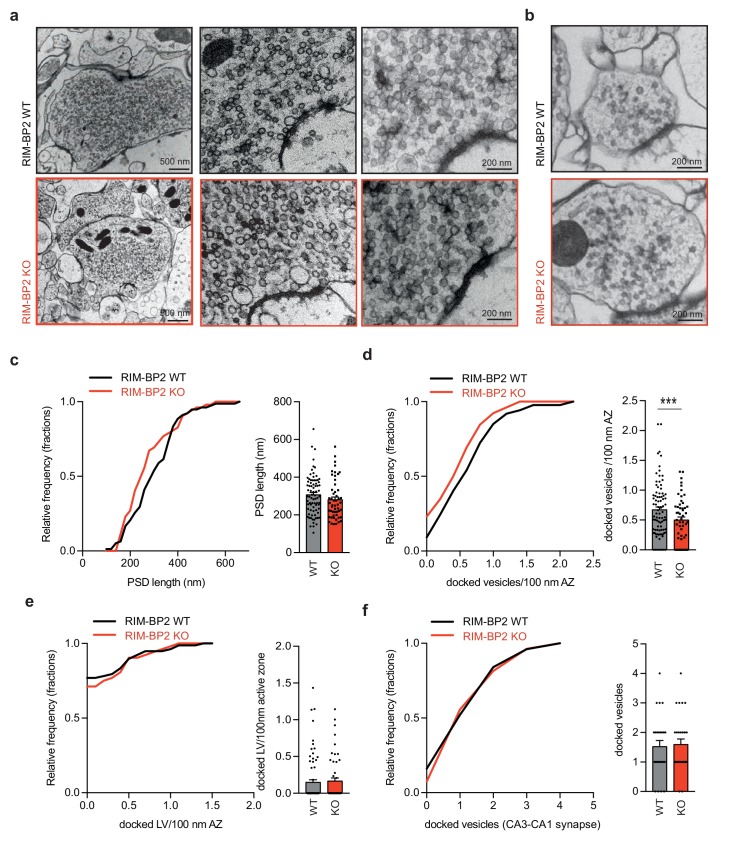
Loss of RIM-BP2 specifically affects vesicle docking at MF synapses.Representative EM images of MF synapses from acute hippocampal slices obtained from RIM-BP2 KO (black: three animals/each2-3 slices/78 active zones) and WT (red: three animals/2–3 slices each/52 active zones) mice. (b) Representative EM images of CA1 synapses from acute hippocampal slices obtained from RIM-PB2 KO (black: three animals/each2slices/27 active zones) and WT (red: three animals/2 slices each/25 active zones) mice. (c) Frequency distribution and bar graph show no difference in the size in the post-synaptic density (PSD) in MF active zones from WT or RIM-BP2 KO slices. (d) Frequency distribution and bar graph show a reduction of docked vesicles per 100 nm of the active zone at RIM-BP2 KO MF synapse compared to WT MF synapses. (e) Frequency distribution and bar graph depict no difference in the number of docked large vesicles (LV) (vesicle diameter >70 nm) (f) Frequency distribution and bar graph of docked vesicles at CA3-CA1 synapses show no difference between WT and RIM-BP2 KO. Values represent mean ± SEM. *p<0.05, **p<0.01, ***p<0.001. For statistics please see Figure 4—source data 1.10.7554/eLife.43243.019Figure 4—source data 1.Statistics of data presented in Figure 4.